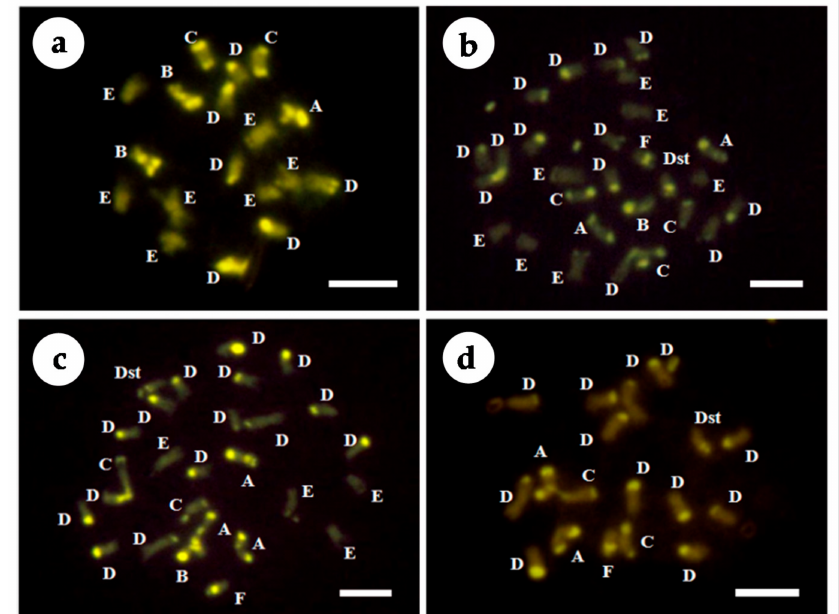
Figure 4. CMA staining of the somatic chromosomes at metaphase in young leaves of ‘Kiyomi’ tangor, Meiwa kumquat, and their hybrids. ( a ) ‘Kiyomi’ tangor (2n = 2x = 18), ( b ) H15-701 (2n = 28), ( c ) H15- 702 (2n = 3x = 27), ( d ) Meiwa kumquat (2n = 2x = 18). A = two telomeric bands and one proximal band, B = one telomeric and one proximal band, C = two telomeric bands, D = one telomeric band, E = no band, F = one proximal band, and Dst = type D with a satellite chromosome. Bar represents 5.0 µ m for all